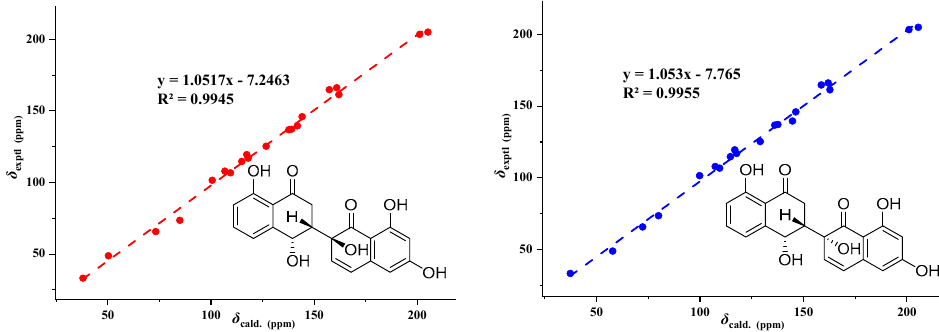
Figure 7. Linear regression analysis between experimental and calculated 13 C NMR chemical shifts